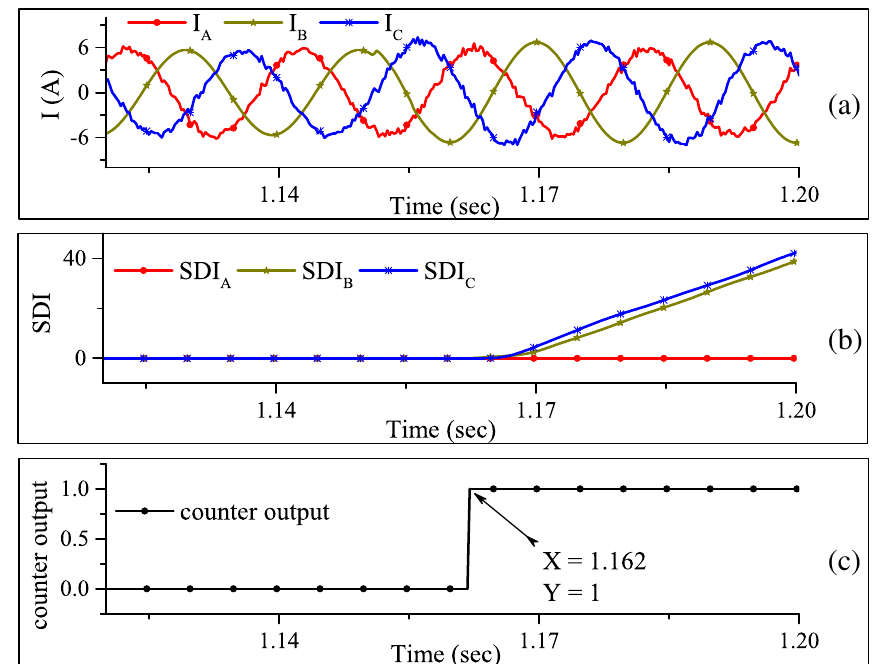
Fig. 8 Fault occurred at the presence of Noise, ( a ) Current waveforms, ( b ) SDI trajectories ( c ) counter output